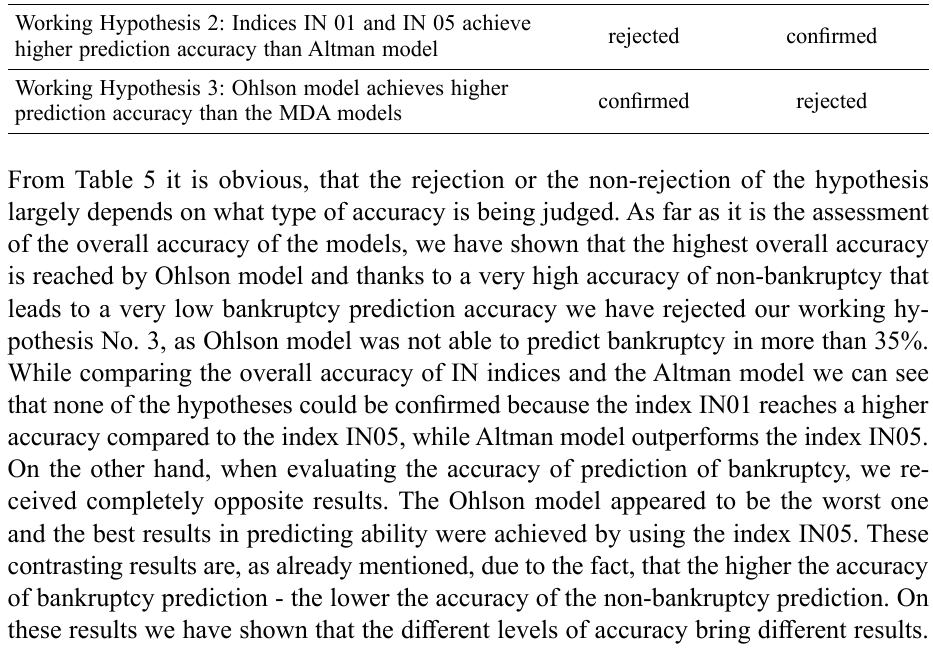
Total prediction